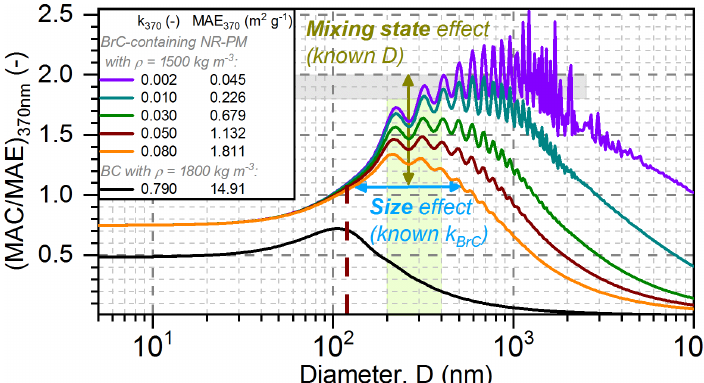
Figure B1. Effect of particle size on the MAC / MAE ratios at 370nm for BrC-containing NR-PM particles with absorptivity up to that of pure BC. The different curve colours correspond to approximate absorptivity of individual methanol-extracted fractions determined by UV– vis–PMF (orange: WINS-BBOA; brown: methanol-soluble BBOA; green: WOOA; dark cyan and violet: range of “other OA” absorptivity). The light-green box and thick dashed brown line indicate the larger size range mode and the lower limit, respectively, considered for Mie calculations. The light-grey box indicates the MAC / MAE range of 1.8–2.0 previously reported in the